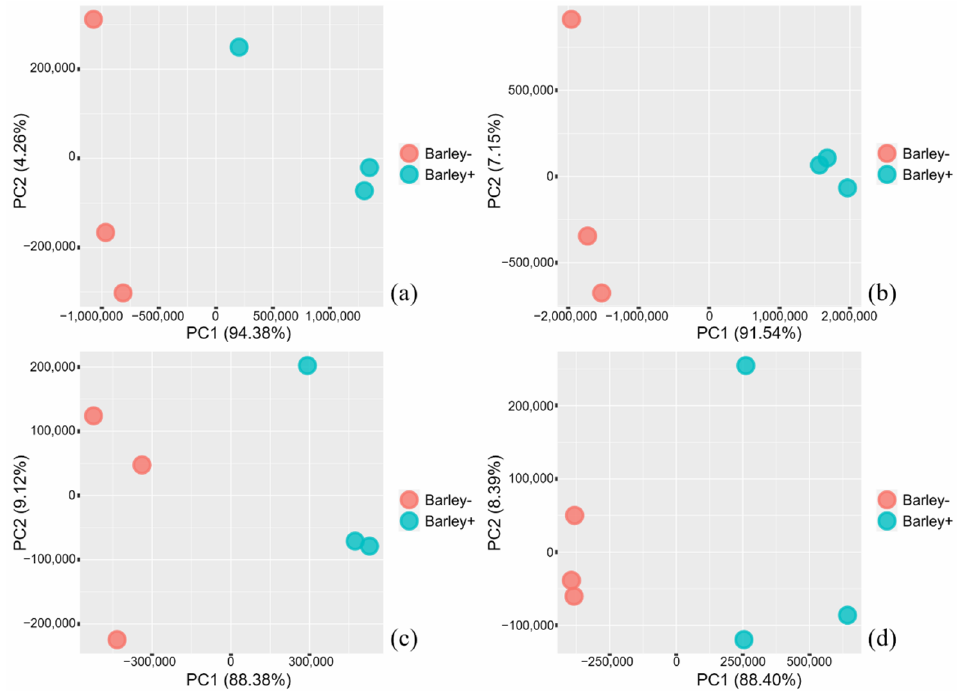
Figure 1. Principal component analysis (PCA) plots representing the clustering of biological replicates based on gene expression levels of ( a ) strain AR ( E. gerundensis ) in Nutrient Broth, ( b ) S25 ( Paenibacillus sp.) in Nutrient Broth, ( c ) S02 ( Paenibacillus sp.) in Nutrient Broth, and ( d ) S02 ( Paenibacillus sp.) in Burk’s N-free medium. Percentage variance explained by each axis is given in brackets. Distinctive clusters that represented the presence (Barley+)/absence (Barley − ) of seedlings formed along the PC1 axis, demonstrating the changes in transcriptome profiles caused by the plant–bacteria interactions.